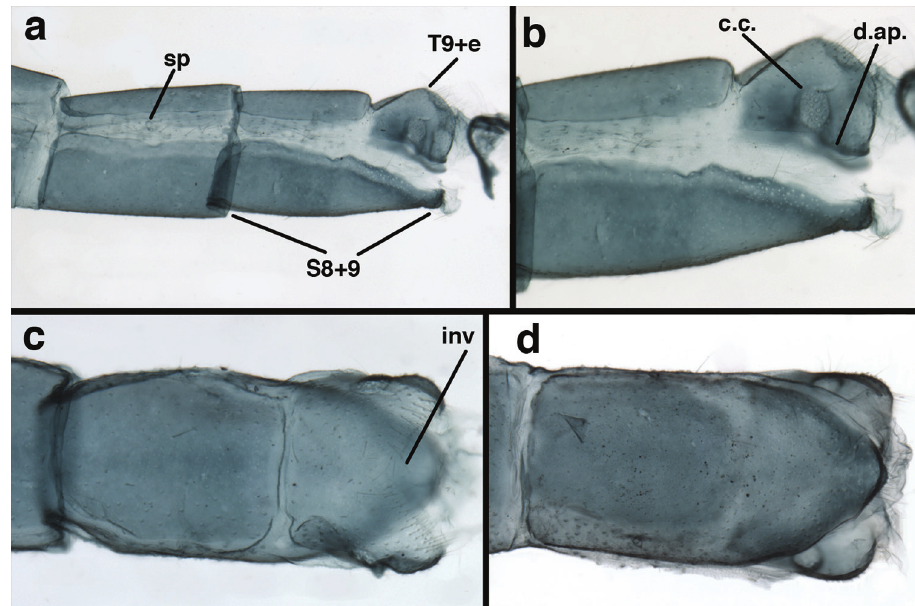
Figure 55. Ungla laufferi (Navás): Male abdomen, ( a ) segments A7-terminus, lateral ( b ) segments A8-terminus, lateral ( c ) tergite 8, tergite 9+ectoproct, dorsal ( d ) sternite 8+9, ventral. c.c. callus cerci d.ap. dorsal apodeme inv dorsal invagination of T9+ectoproct sp spiracle S8+9 fused eighth and ninth sternites T9+e ninth tergite + ectoproct ( a–c Peru, Lima, FSCA; d same,